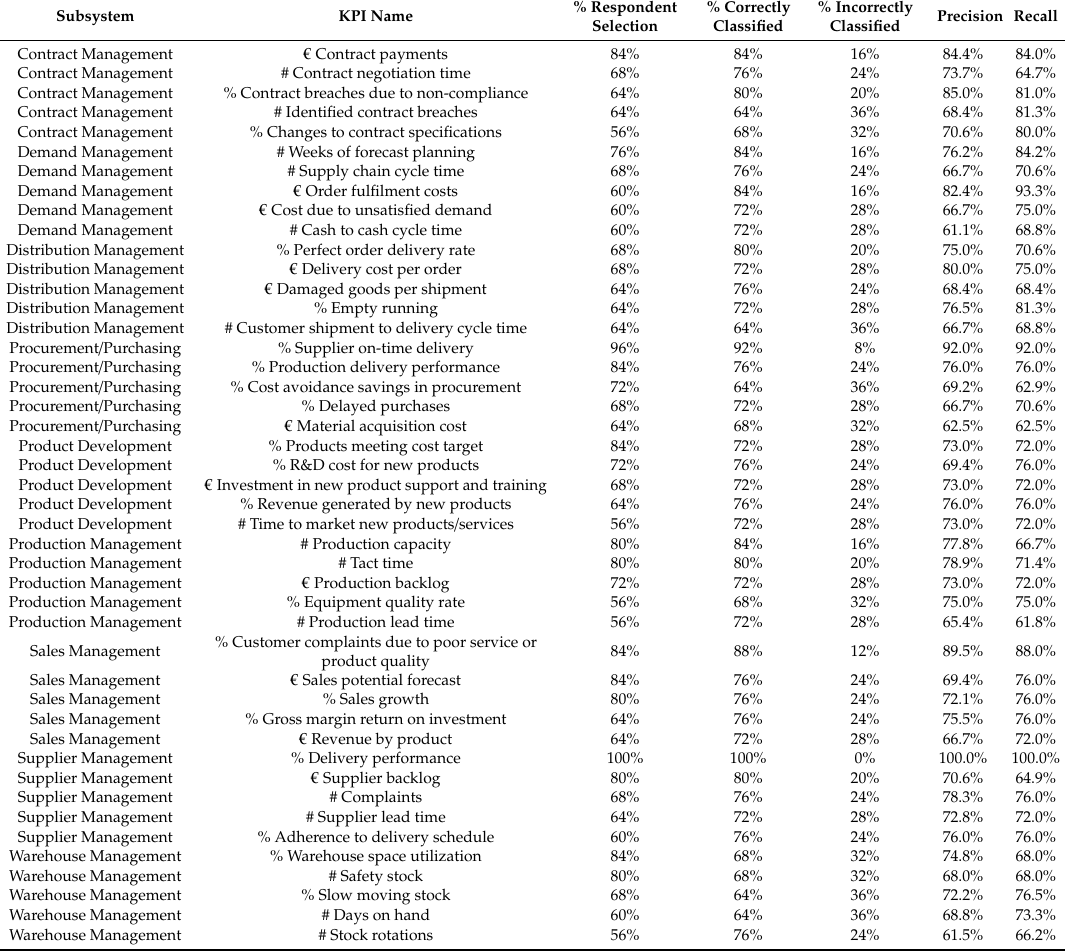
Table 3. Output of the WEKA software using the MLP algorithm for the top 45 KPIs.